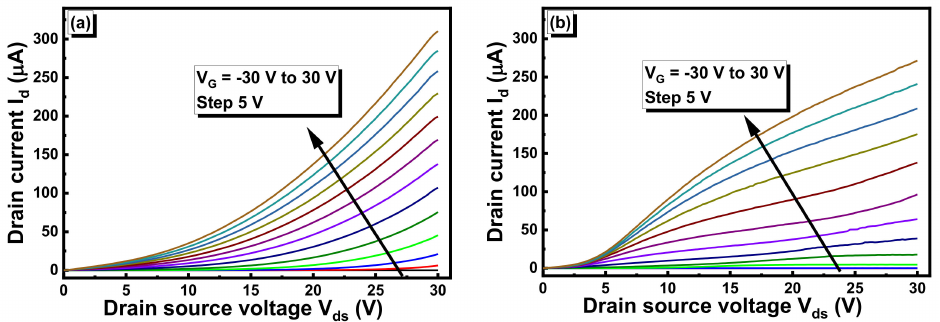
Figure 3. I d -V ds characteristics of the fabricated devices on ( a ) SiO 2 /Si substrates and ( b ) SiN/Si substrates, at different gate voltages.